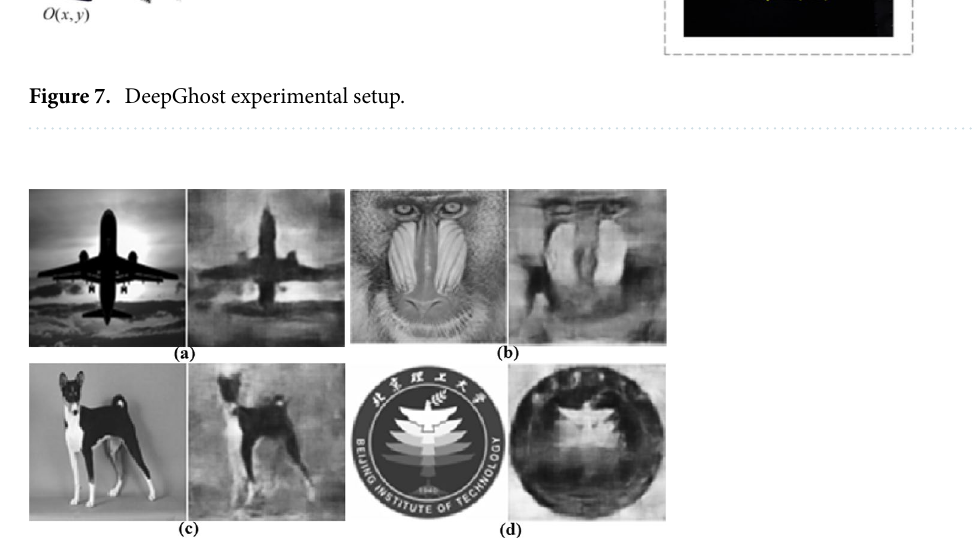
Figure 8. Reconstructions by simulation-trained model on diverse images at S = 0.4 . ( a ) SSIM = 0.5521, PSNR = 17.20 dB, ( b ) SSIM = 0.4812, PSNR = 13.22 dB, ( c ) SSIM = 0.6014, PSNR = 19.91 dB, ( d ) SSIM = 0.4613, PSNR = 14.56